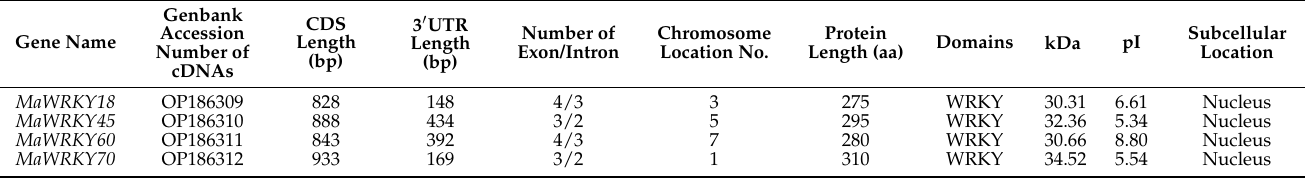
Table 1. Relevant features of MaWRKY18 , MaWRKY45 , MaWRKY60 , and MaWRKY70 cDNAs and their deduced proteins.